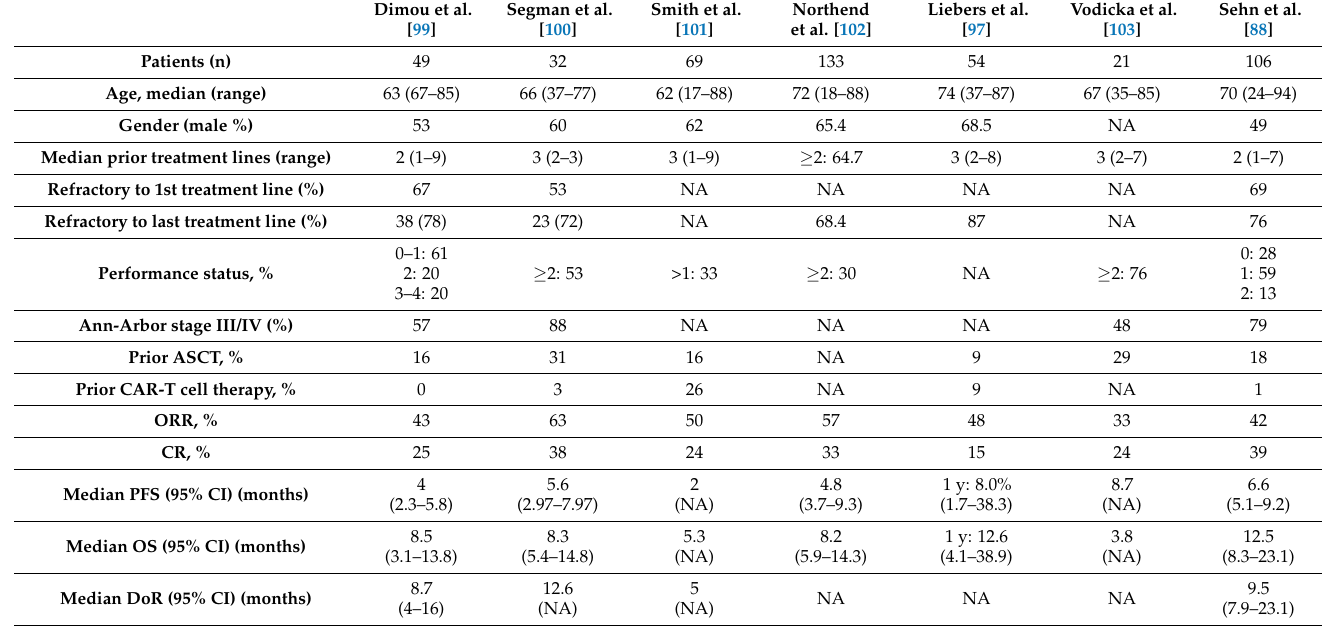
Table 5. Clinical trial and real-life data evaluating the efficacy of polatuzumab vedotin in combination with bendamustine and rituximab in patients with relapsed refractory diffuse large B-cell lymphoma. Dimou et al. Segman et al. Smith et al. Northend Liebers et al. [99] [100] [101] et al. [102]